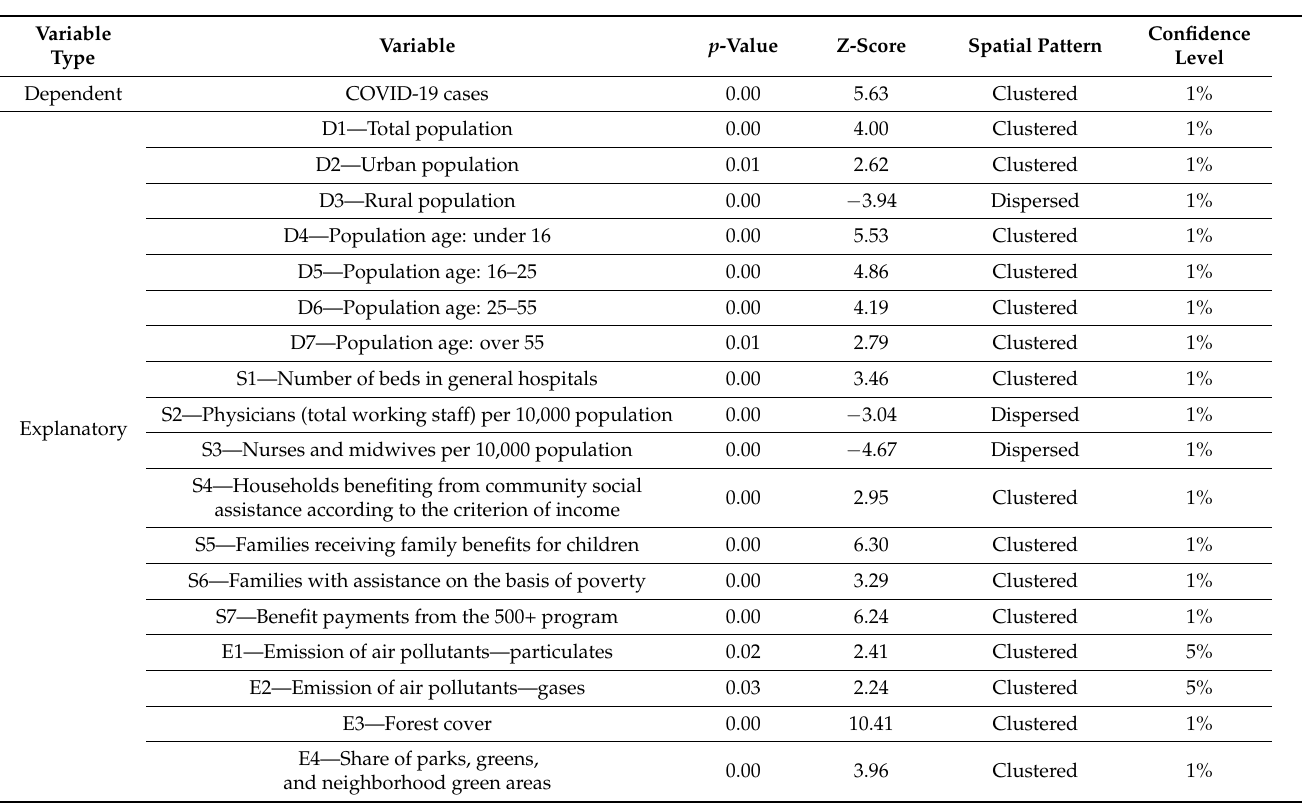
Table 2. Summary of the spatial autocorrelation. Source: own elaboration on the basis of ArcGIS Pro 2.9 by Esri.